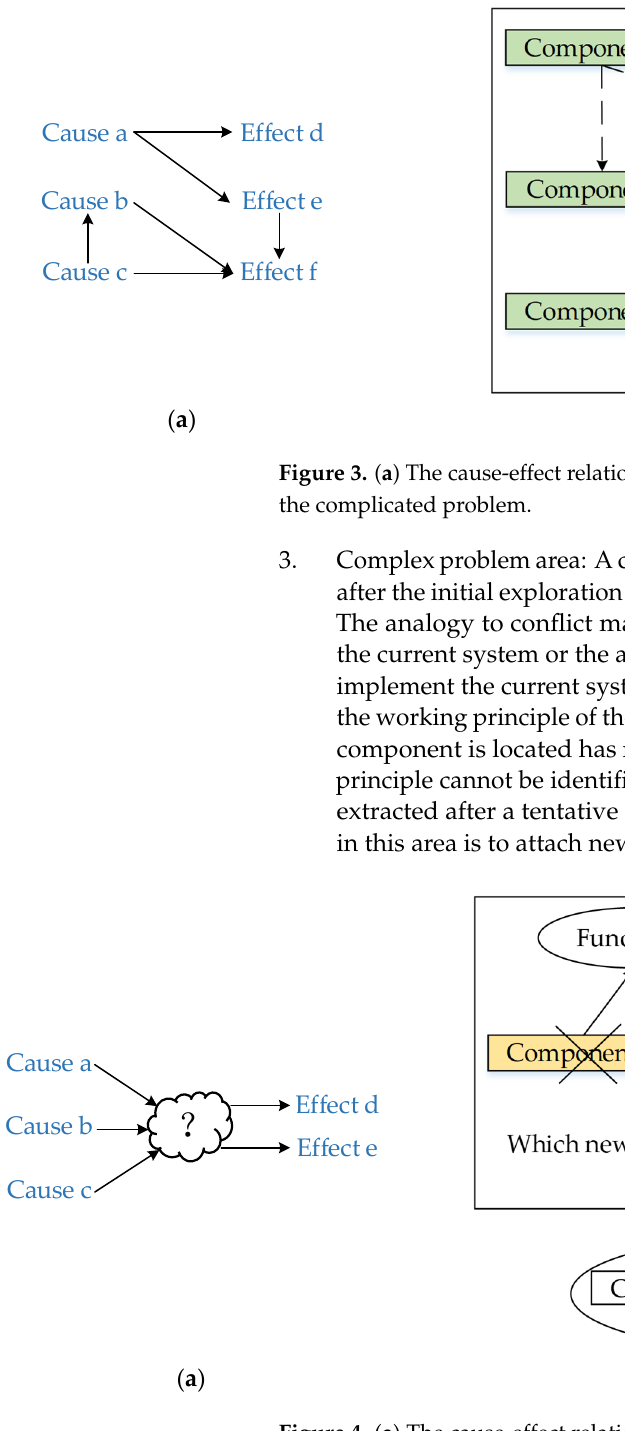
Figure 4. ( a ) The cause-effect relationship of the complex problem; ( b ) The conflict relationship of a complex problem.